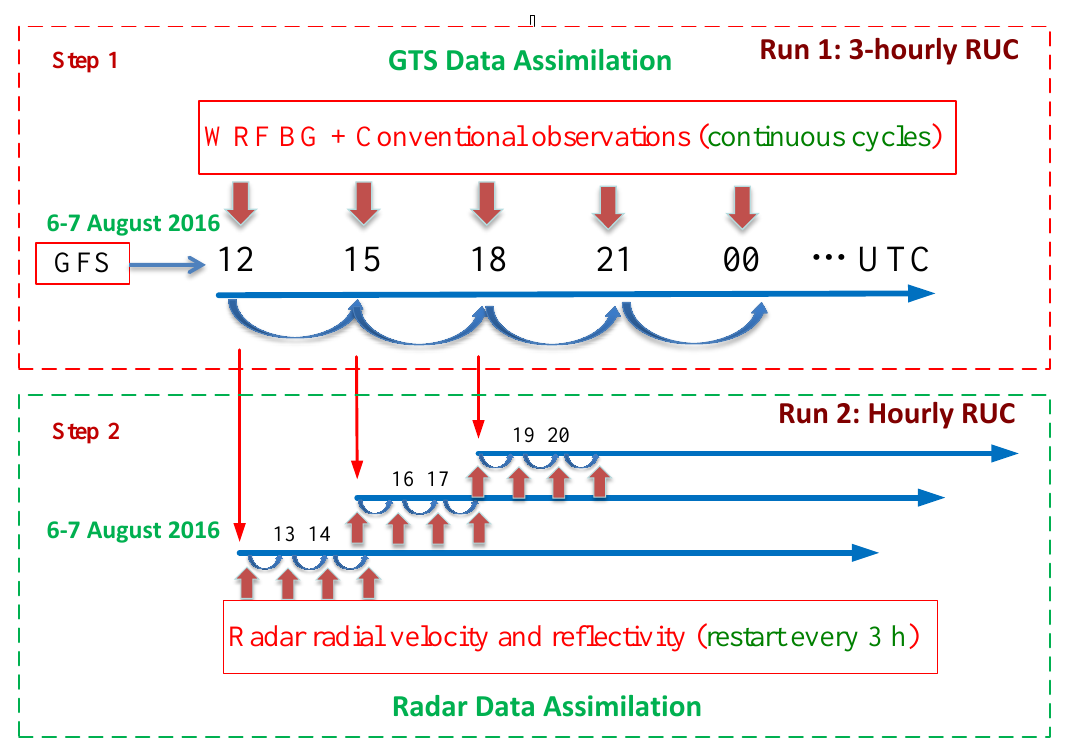
Figure 5. Diagram illustrating two-step procedure of radar data assimilation. In Step 1 (red dashed box), conventional observations from Global Telecommunications System (GTS) are assimilated with three-hourly update cycles. In Step 2 (green dashed-box), radar data are assimilated with hourly update cycles.